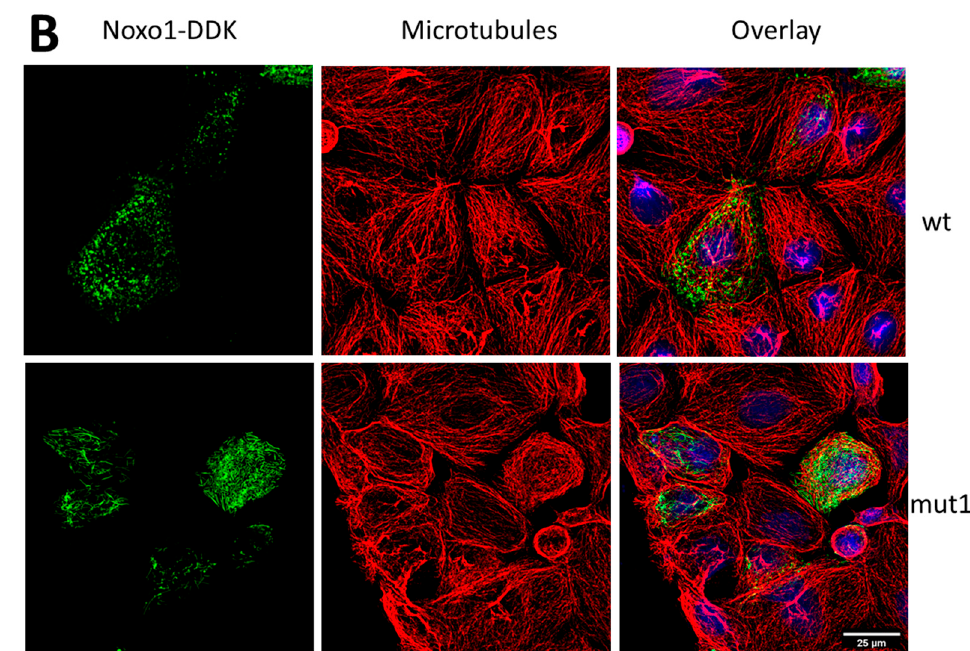
Figure 10. Immunofluorescence Noxo1 with F-actin or microtubules in Caco-2 transfected with wt Noxo1- or mut1 Noxo1-DDK. ( A ) Immunofluorescence of Noxo1-DDK and F-actin. Wt-Noxo1 and mut1-Noxo1 (green, upper and lower left panel), F-actin (red, middle panel), and overlay corresponding to Noxo1-DDK/F-actin/nucleus (using DAPI) (left panel). ( B ) Immunofluorescence of Noxo1-DDK and microtubules. Wt-Noxo1 and mut1-Noxo1 (green, upper and lower left panel), microtubules (red, middle panel), and overlay corresponding to Noxo1-DDK/microtubules /nucleus (using DAPI) (left panel). Scale bar in all panels: 25 µm. There is no particular colocalization of Noxo1 with F-actin except for a few peripheral membrane areas for either the wt or mut1 form of Noxo1 (Figure 10A). This rather un- common colocalization is compatible with the regulation of Nox and actin by Rho- GTPases in membrane signaling hubs. Microtubule organization in cells transfected with